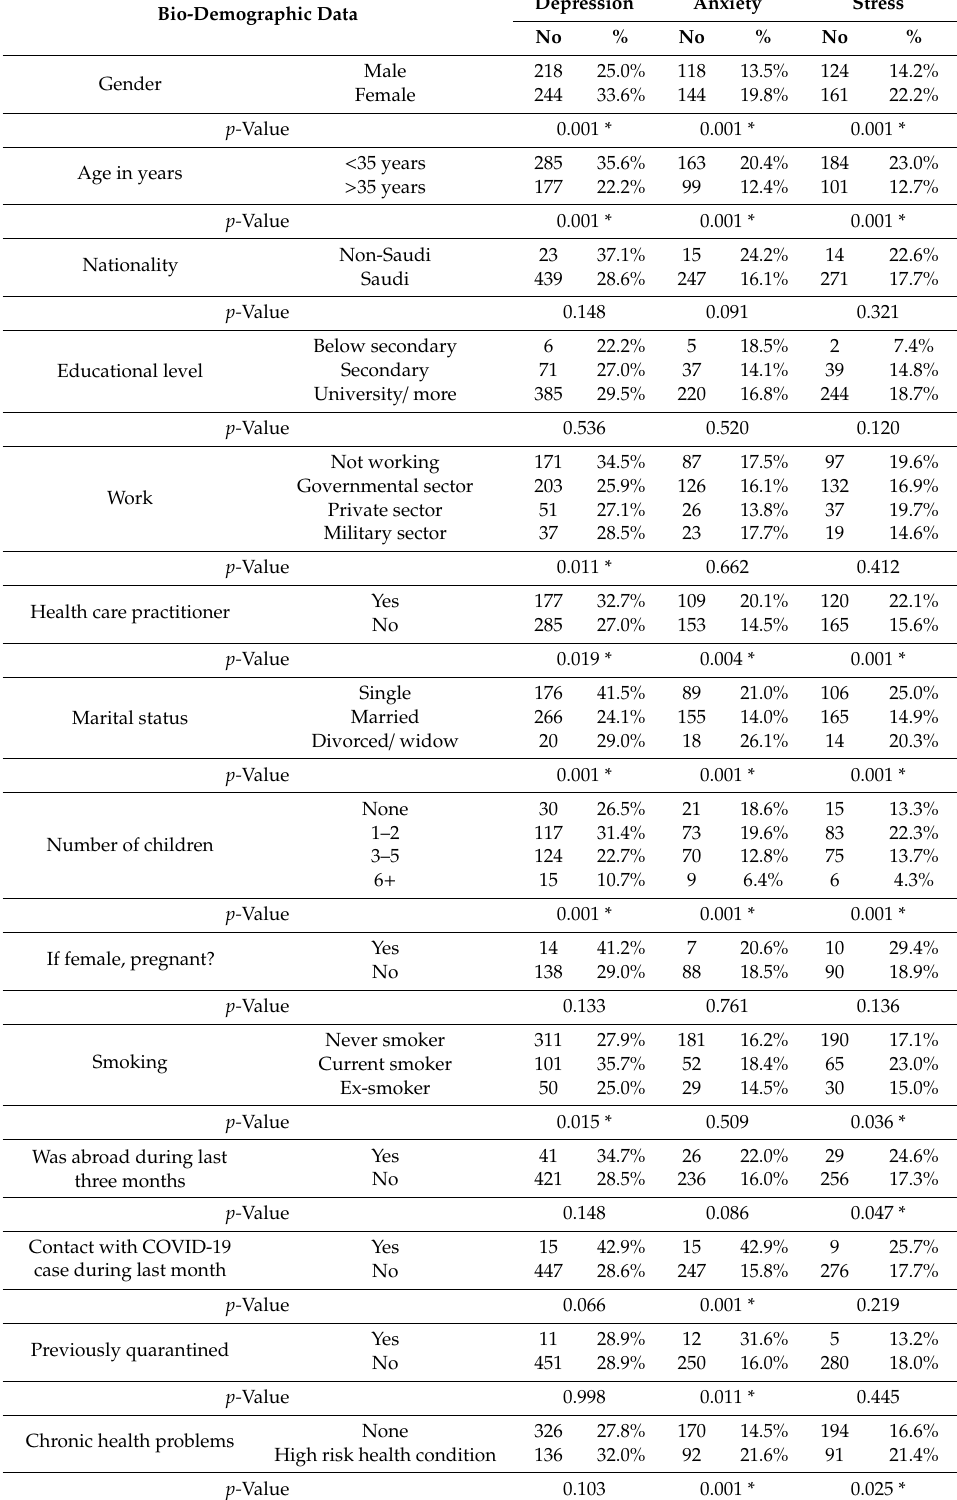
Table 5. Distribution of participants psychological health aspects by their biodemographic